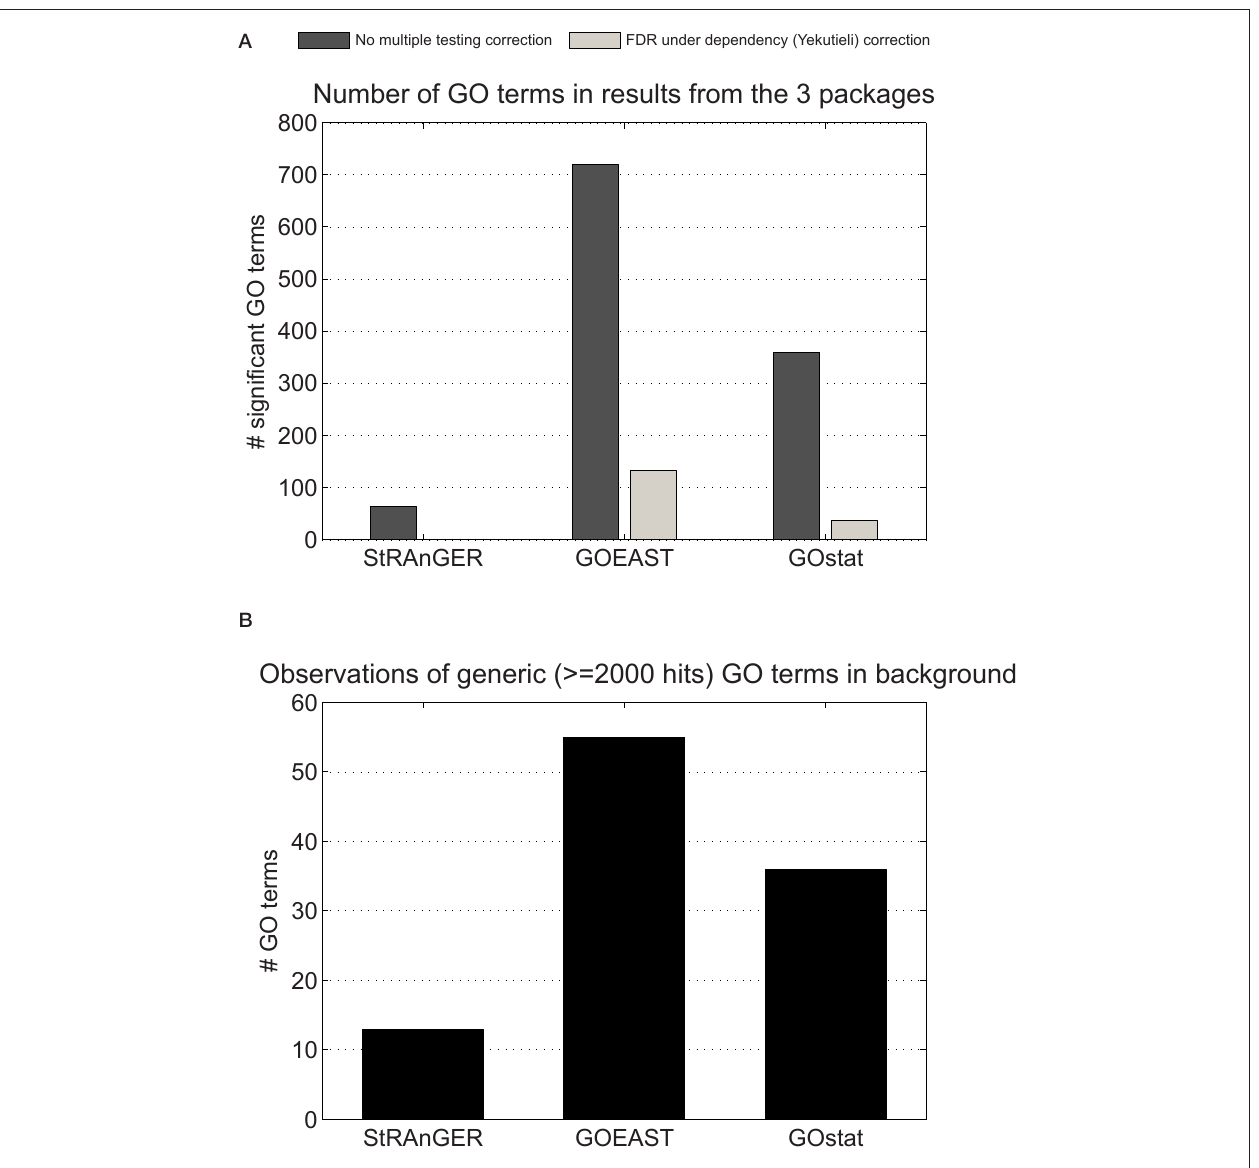
bootstrapping applied estimates the GO term distribution cutoffs. (B) . Number of the resulting, statistically significant GO terms, representing very general biological functions (i.e. “protein binding”) yielded by the 3 software packages described in the main text. StRAnGER’s main algorithm manages to filter out many of